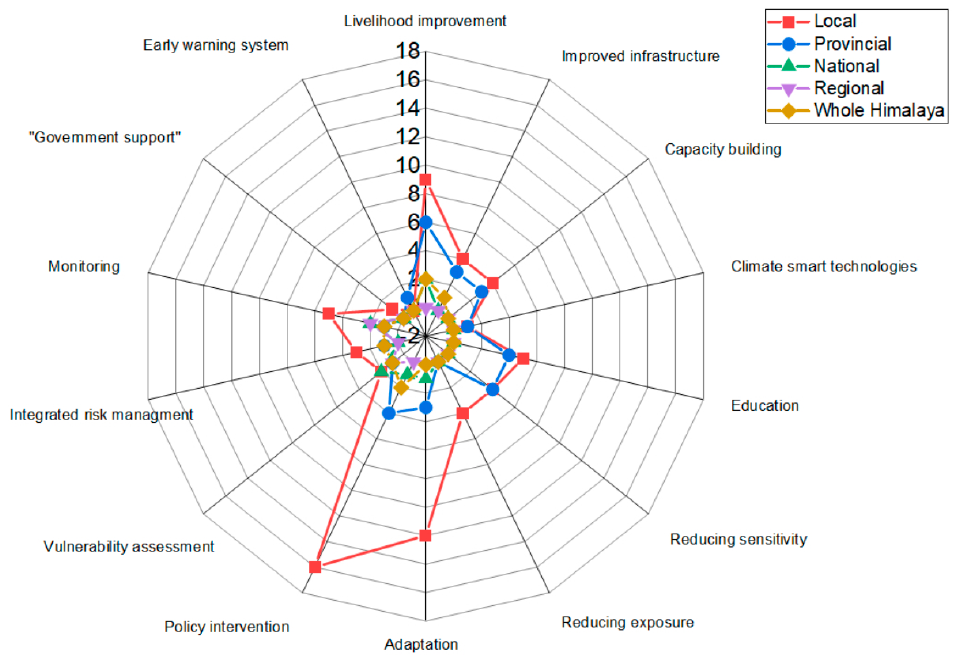
Figure 5. The number of studies and recommendations for vulnerability mitigation at different levels in the Himalayas.